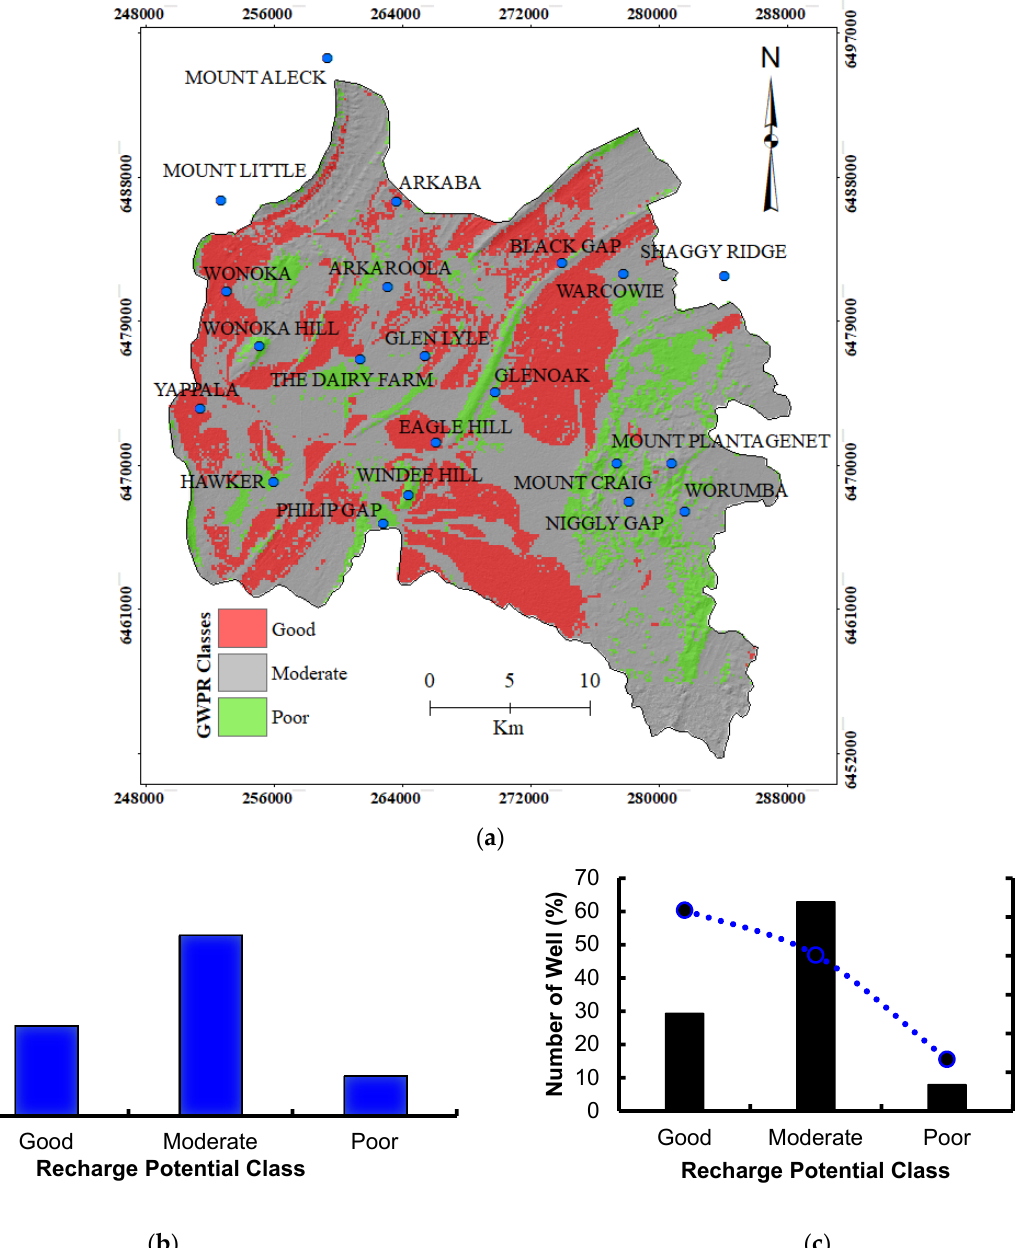
Figure 8. ( a ) Recharge potential map, ( b ) Recharge potential classes’ areas and ( c ) Recharge potential classes against number of wells (%) and average yield.